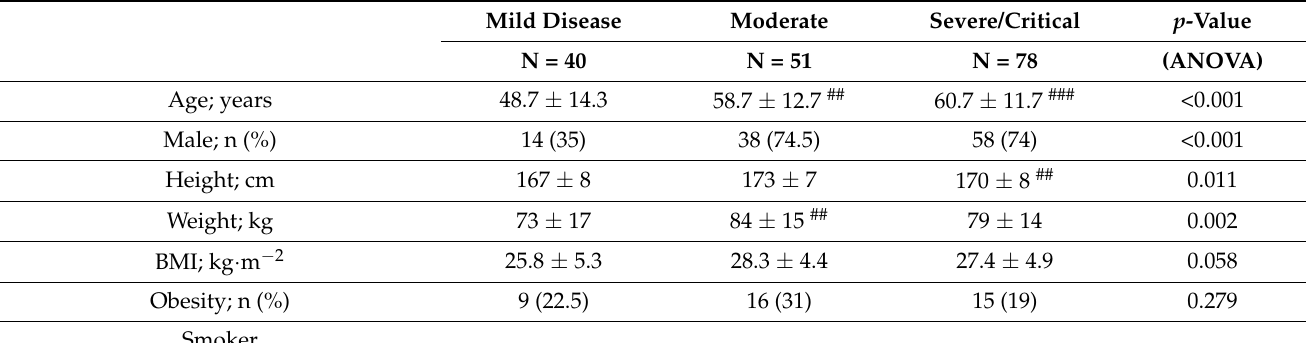
Table 1. Characteristics of the studied population and SARS-CoV-2 pneumonia.